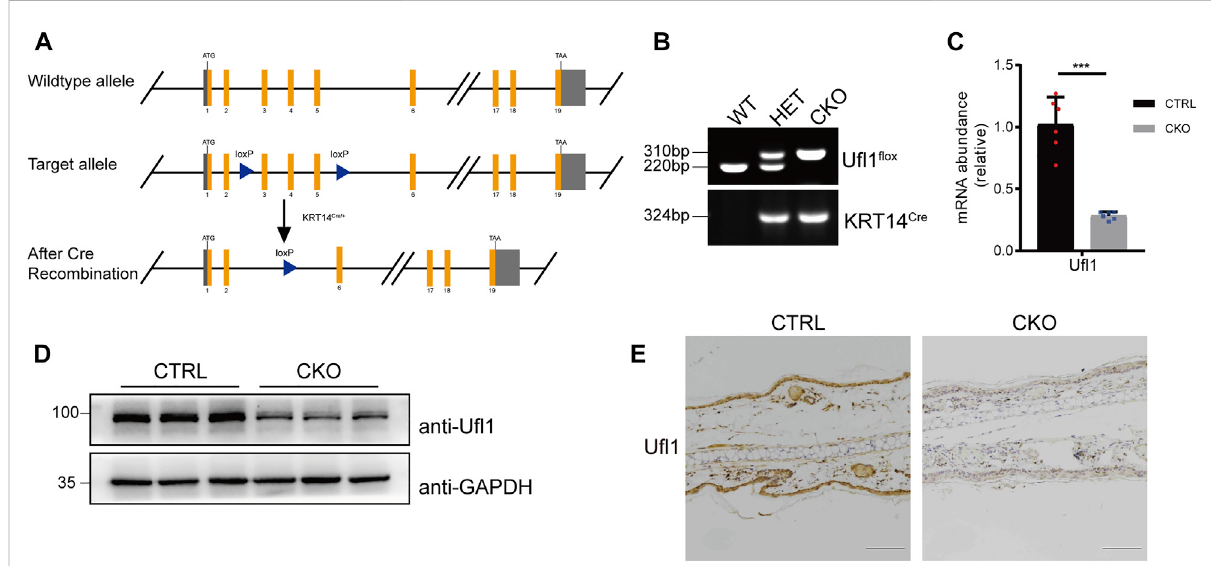
FIGURE 1 Generation of U fl 1 f / f KRT14 Cre/+ mice. (A) Targeting strategy to generate U fl 1 conditional knockout mice. U fl 1 f / f mice were crossed with KRT14 Cre/+ transgenic mice to obtain conditional skin knockout mice. (B) PCR-based genotyping of wild-type and fl oxed alleles of U fl 1 and KRT14- Cre allele. (C) q-PCR analysis of U fl 1 gene expression in the skin of 3-month-old CTRL and CKO mice ( n = 6). (D) U fl 1 expression was detected by Western blot in the skin of 3-month-old CTRL ( U fl 1 f/+ , U fl 1 f/f or U fl 1 f/+ KRT14 Cre/+ ), CKO ( U fl 1 f/f KRT14 Cre/+ ) mice. (E) Immunohistochemical staining (IHC) of U fl 1 proteins in sections of ear skin from CTRL and CKO. *** p < 0.001, unpaired Student ’ s test. Error bars represent ± s.d. The scale bar represents 100 μ